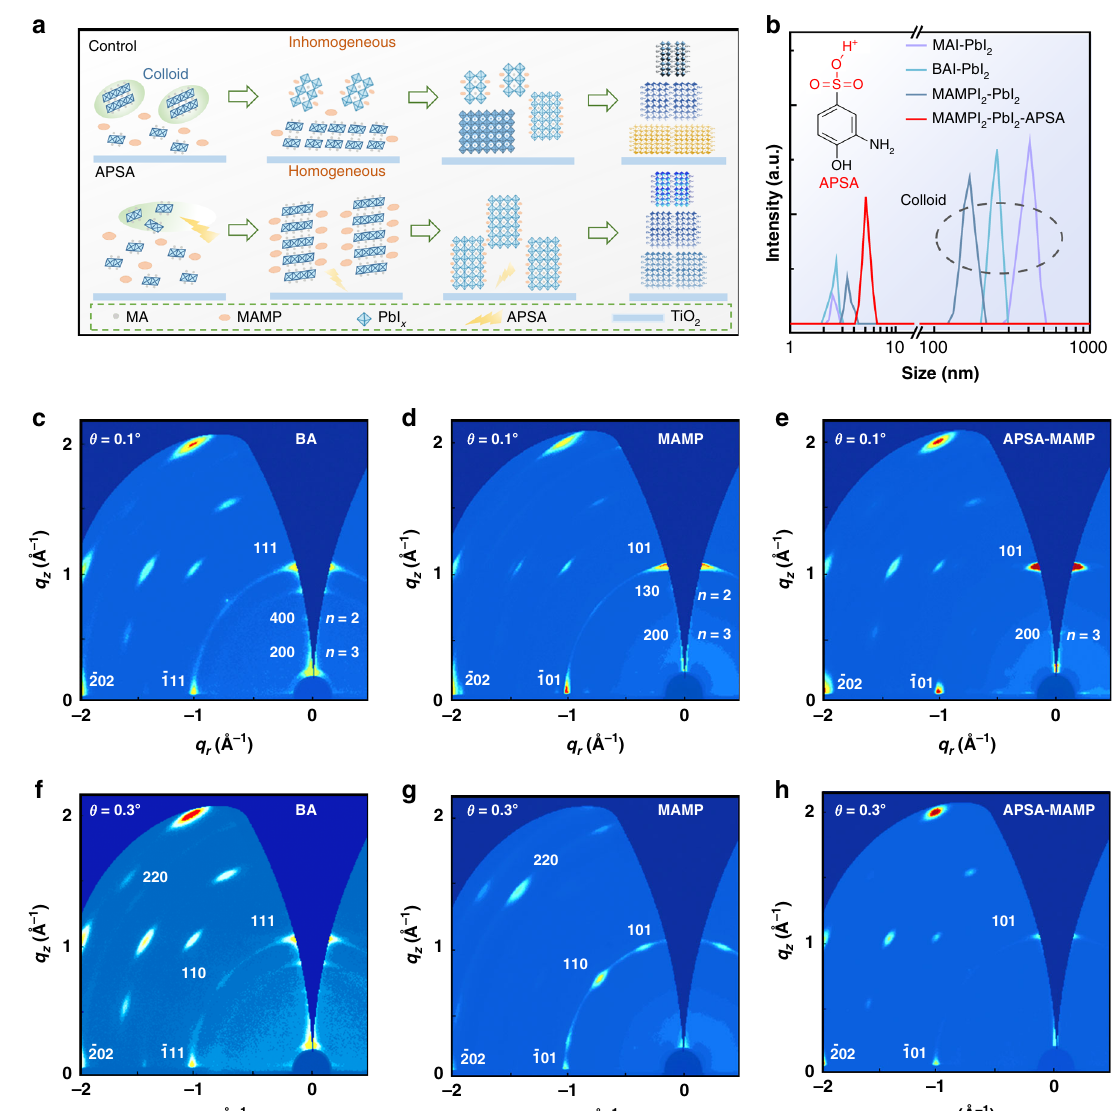
Fig. 2 Crystallization kinetics regulation. a Schematic models indicating crystallization process for both control and APSA-treated quasi-2D perovskite fi lms. b DLS data to evaluate the colloid size and distribution in precursor solutions. Inset: molecular structure of APSA. GIWAXS characterizations for (BA) 2 (MA) 3 Pb 4 I 13 , pristine, and APSA-treated (MAMP)MA 3 Pb 4 I 13 perovskite fi lms, c – e with grazing-incidence angle of 0.1° and f – h with grazing-incidence angle of 0.3°,